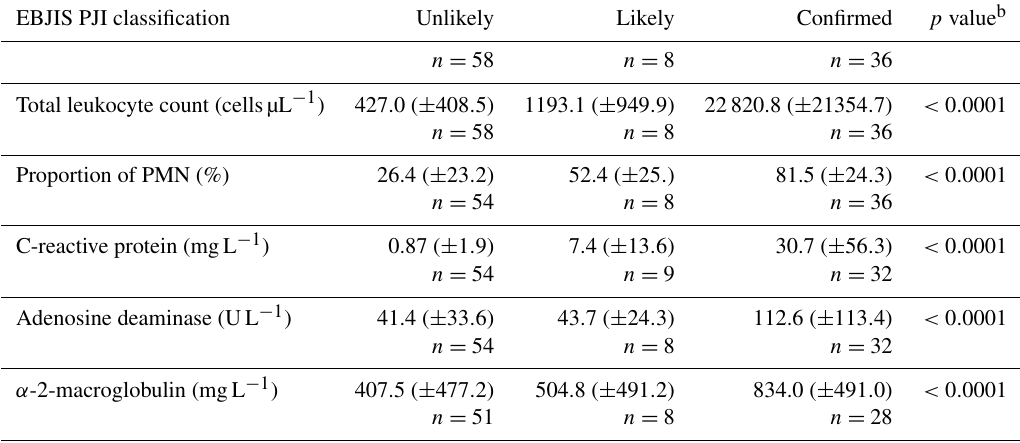
Table 2. Synovial fluid analysis results according to the presence of infection a .